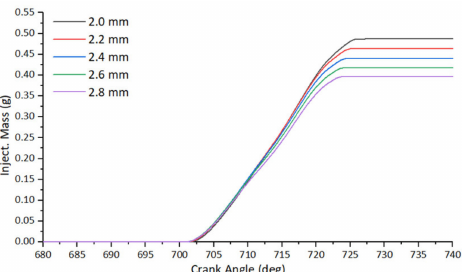
Figure 8. Cumulative fuel injection mass per cycle under varied pipe diameters.